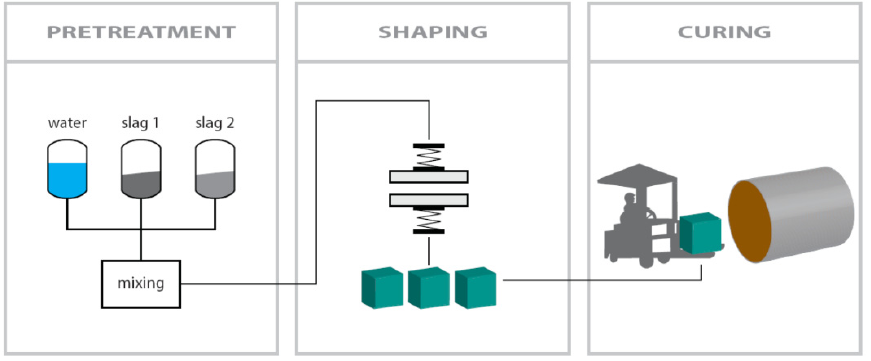
Figure 3. Schematic drawing of the carbonation process at lab-scale [12] .